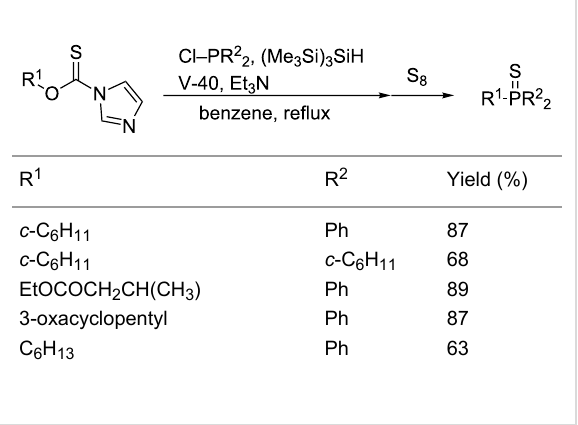
Table 7: Radical phosphination of alkyl imidazole-1-carbothioates.